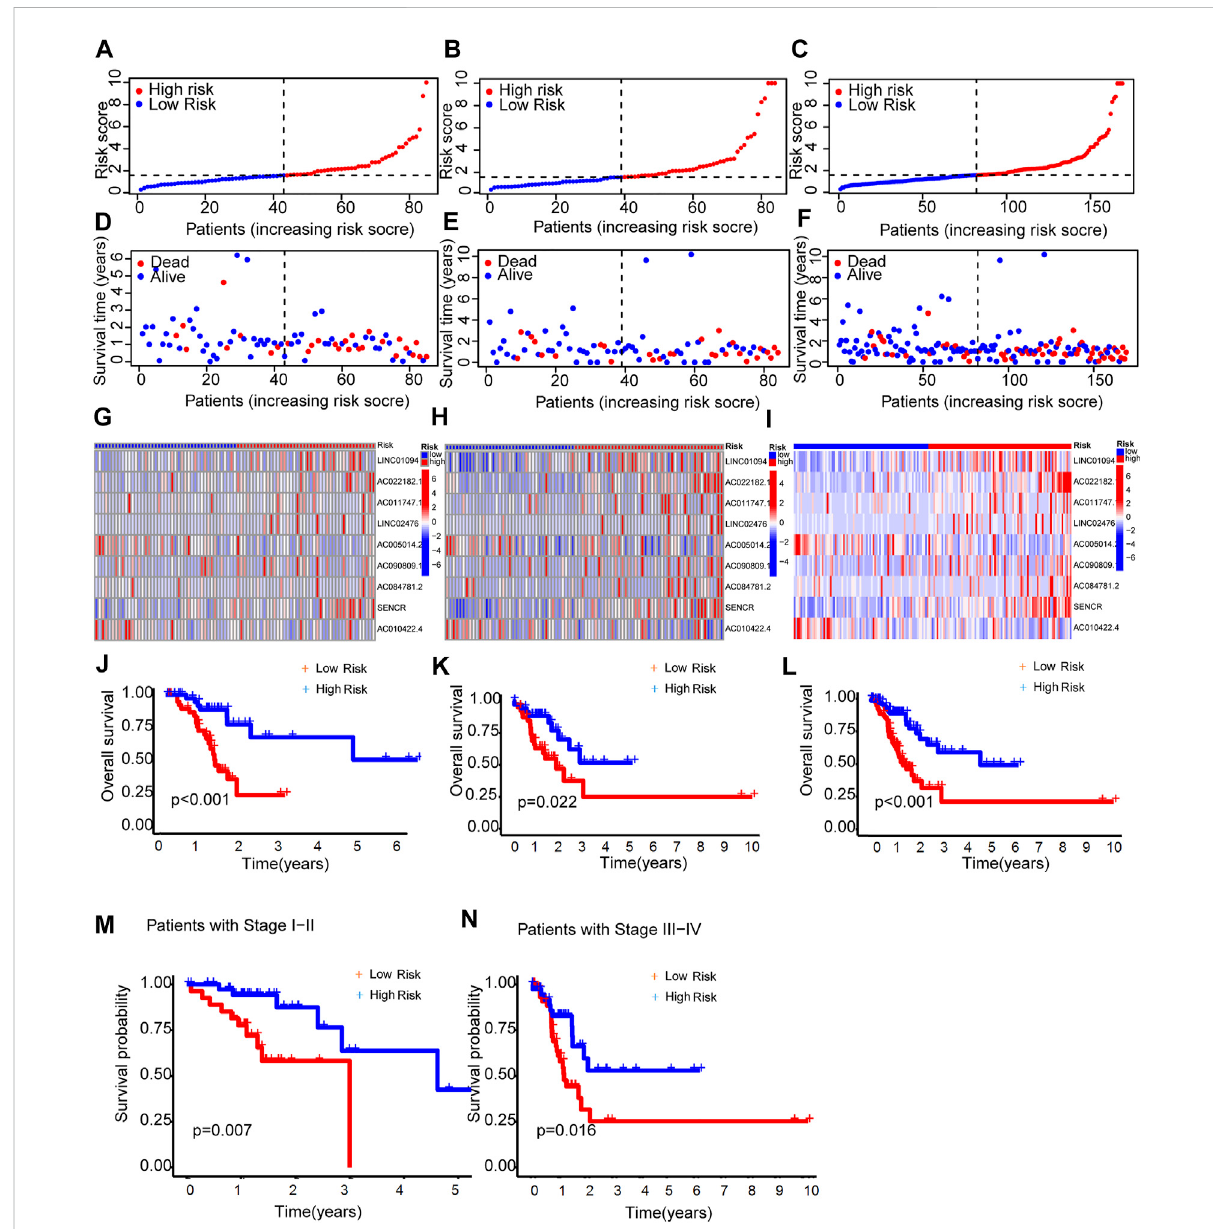
FIGURE 3 Prognosis capability of the model in the three patient sets. (A – C) Distribution of patient with different scores. (D – F) Distribution of patient survival time. (G – I) The heatmap of nine lncRNAs expression. (J – L) Comparison of OS curves of patients between the two groups of each set. (M,N) OS curves of strati fi ed by clinicopathologic characteristics in the entire